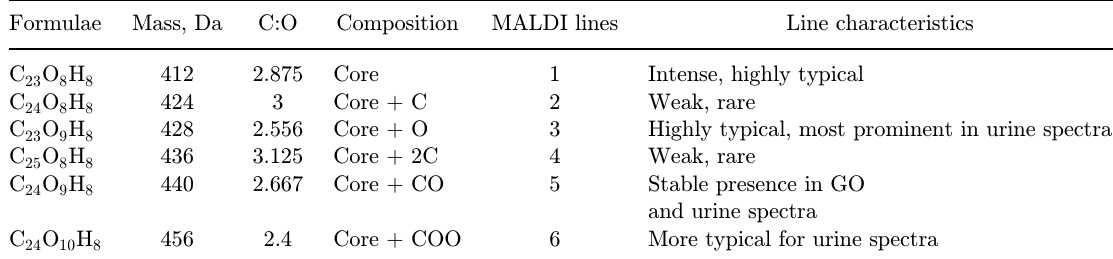
Table 3. Formulae, masses, C/O ratios, composition, designations and characteristics for twinned (GO $ urine) MALDI